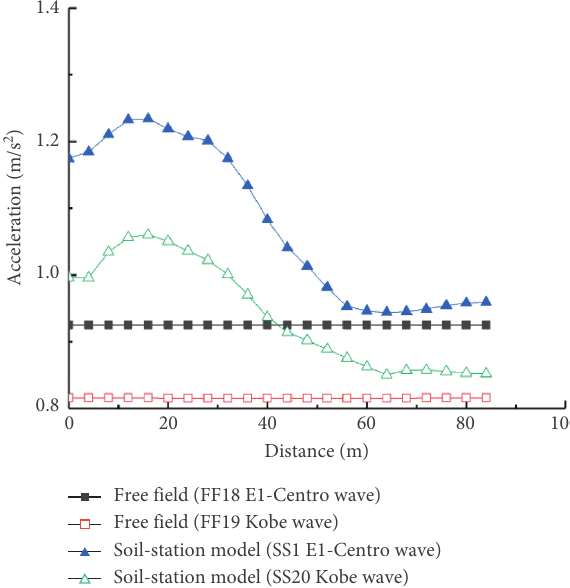
Figure 10: Surface acceleration under different seismic